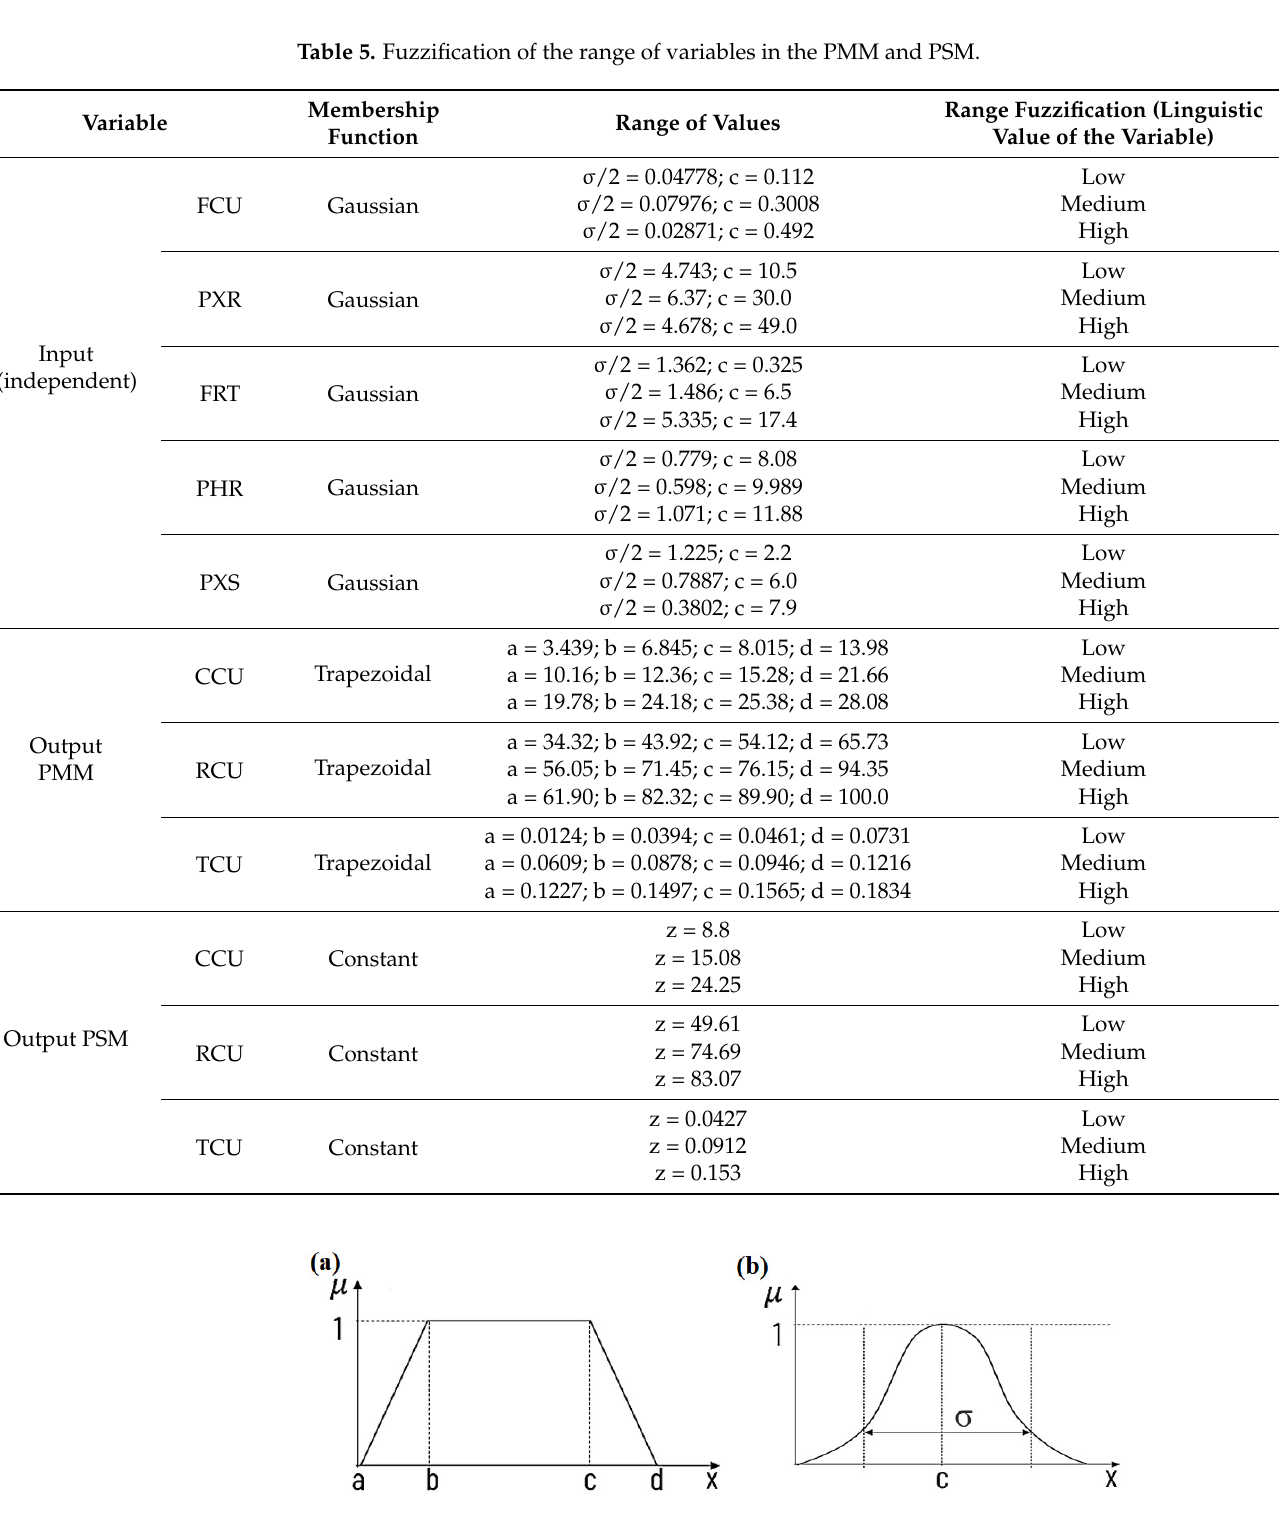
Table 6. Interdependence matrix of parameters in the flotation process. Independent Variable